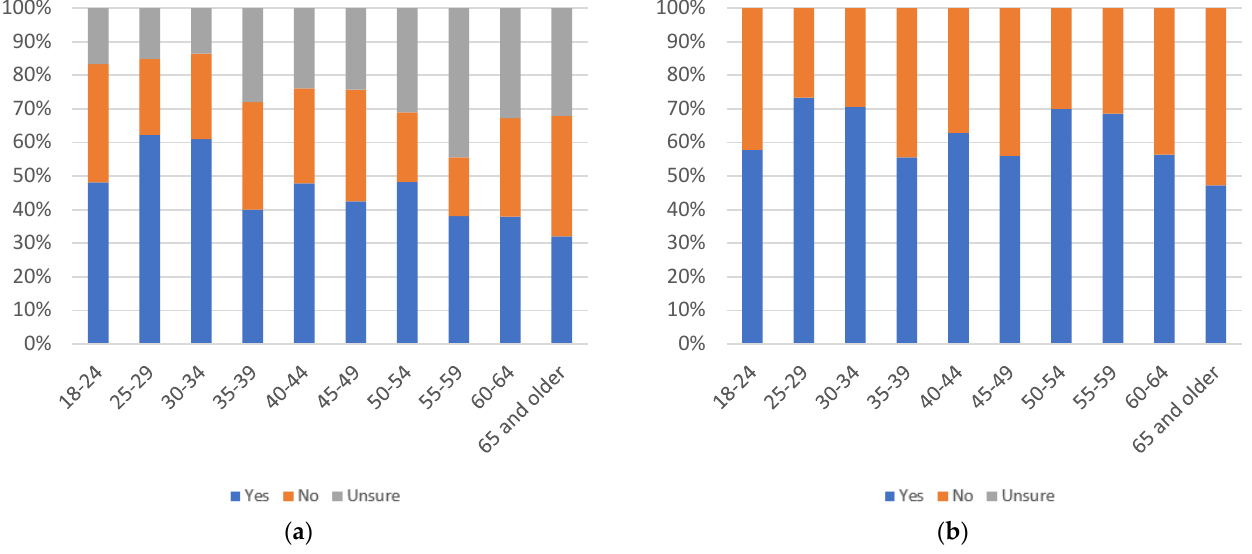
Figure 110. Label others’ use, by age group: ( a ) with uncertain respondents (left) and ( b ) without uncertain respondents (right).